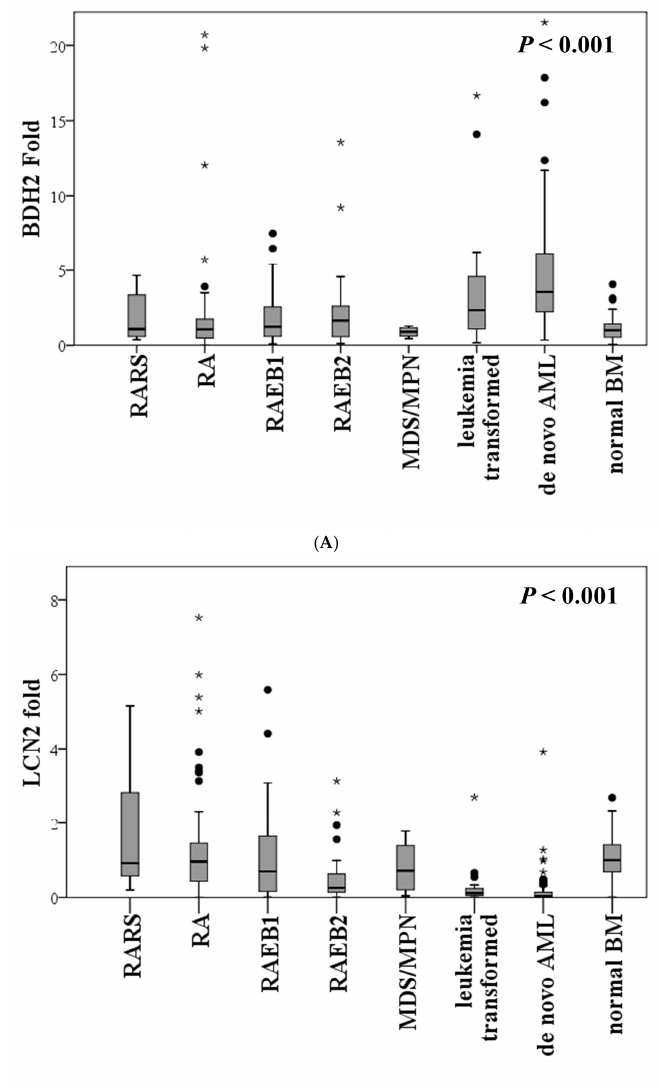
Figure 1. Expression levels of ( A ) BDH2 and ( B ) LCN2 mRNA in BM in MDS and control patients, including de novo CN-AML and normal BM. The expression levels of the BDH2 and LCN2 genes were normalized to the internal control β-actin to obtain the relative threshold cycle (ΔC T ).BDH2, hydroxybutyrate dehydrogenase type 2; BM, bone marrow; CN-AML, cytogenetically normal acute